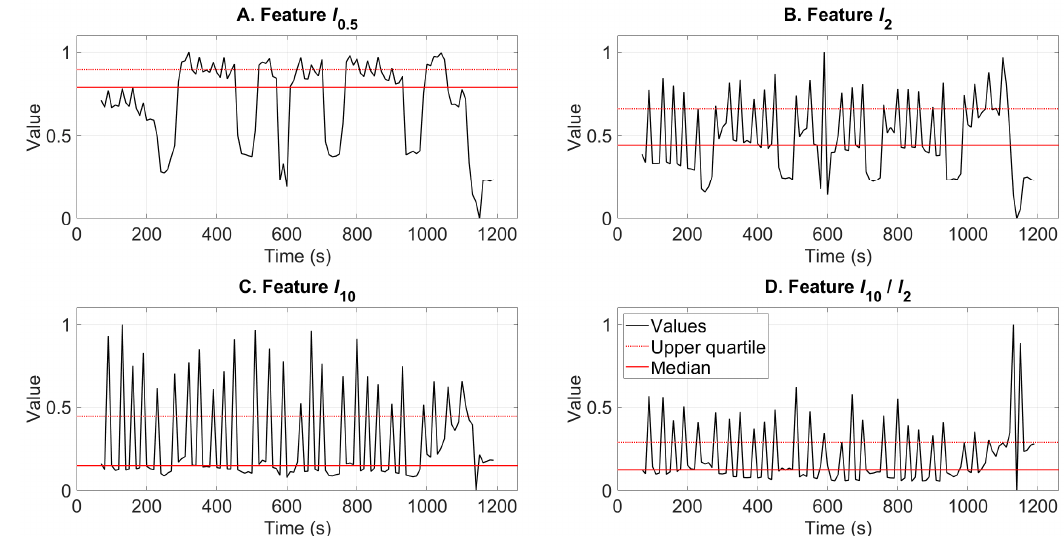
Figure 5. Features sensitive to different phenomena in signals are shown together with their median and upper quartile values. The presented signal was filtered using the 3–4 kHz frequency band.